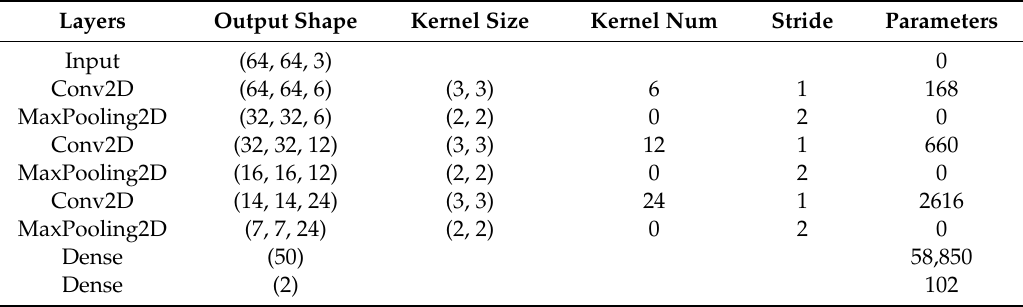
Table 1. The CNN structure and parameters in the Siamese network.